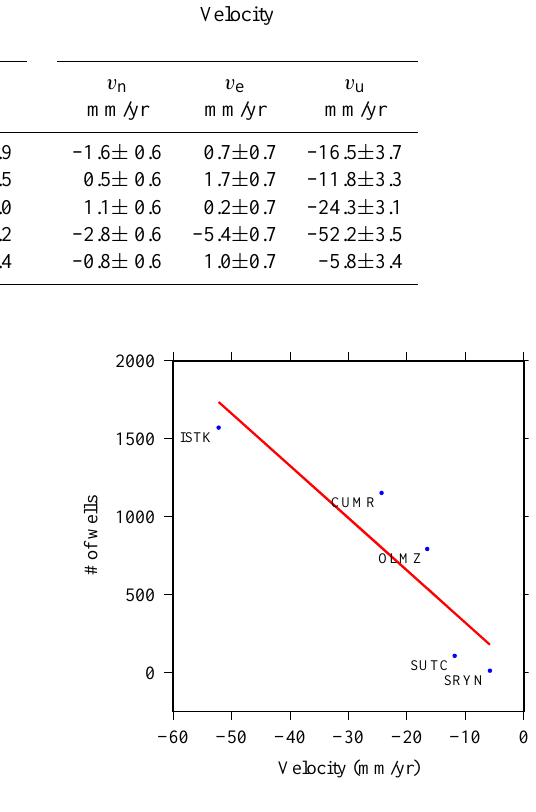
Fig. 4. Correlation between the land subsidence rates and the use of groundwater around the GNSS sites.